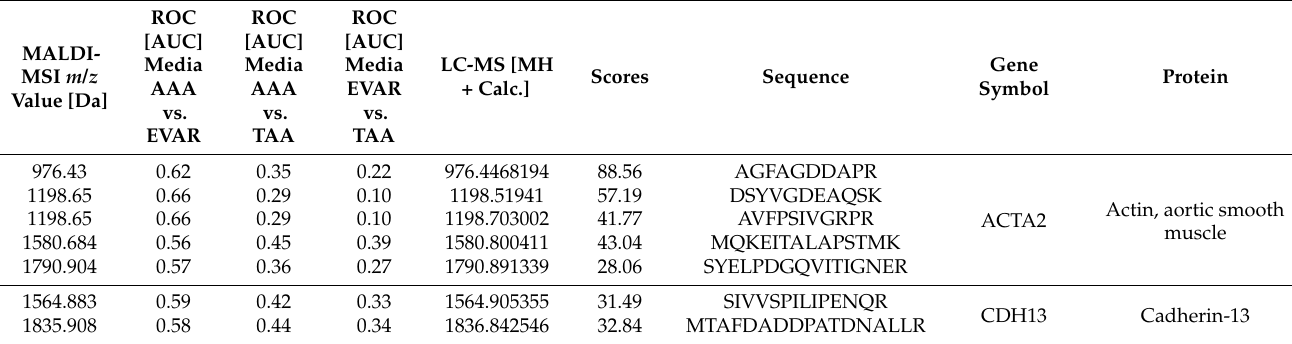
Table 2. Differential peptides (MALDI-MSI) and their corresponding proteins from the tunica media in TAA, AAA, and EVAR tissue